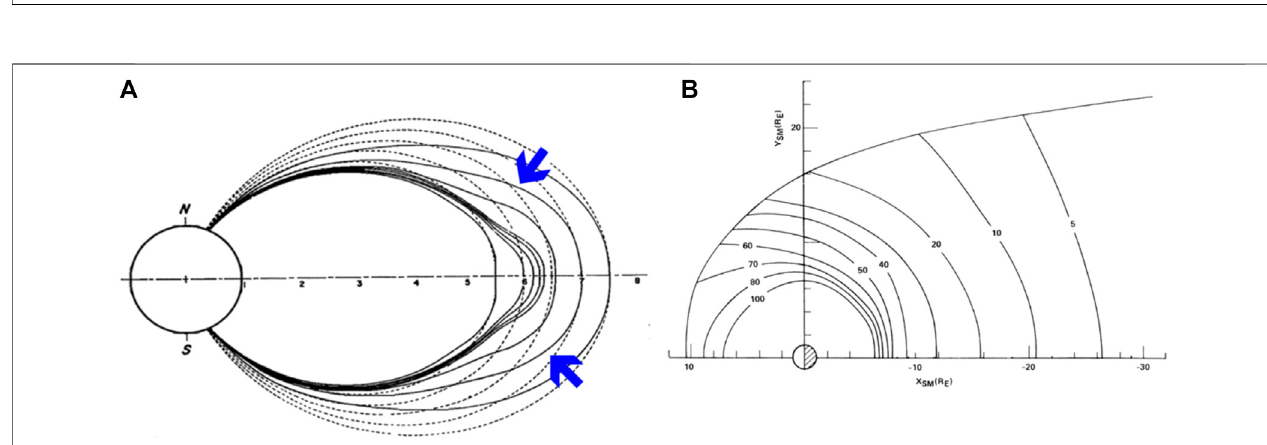
FIGURE 11 | (A) The fi gure shows the direction of the fl ow of power generated by the solar-wind-magnetosphere dynamo and resulting in fl ation of the magnetosphere. (B) The magnetospheric current on the equatorial plane (Olson, 1984).